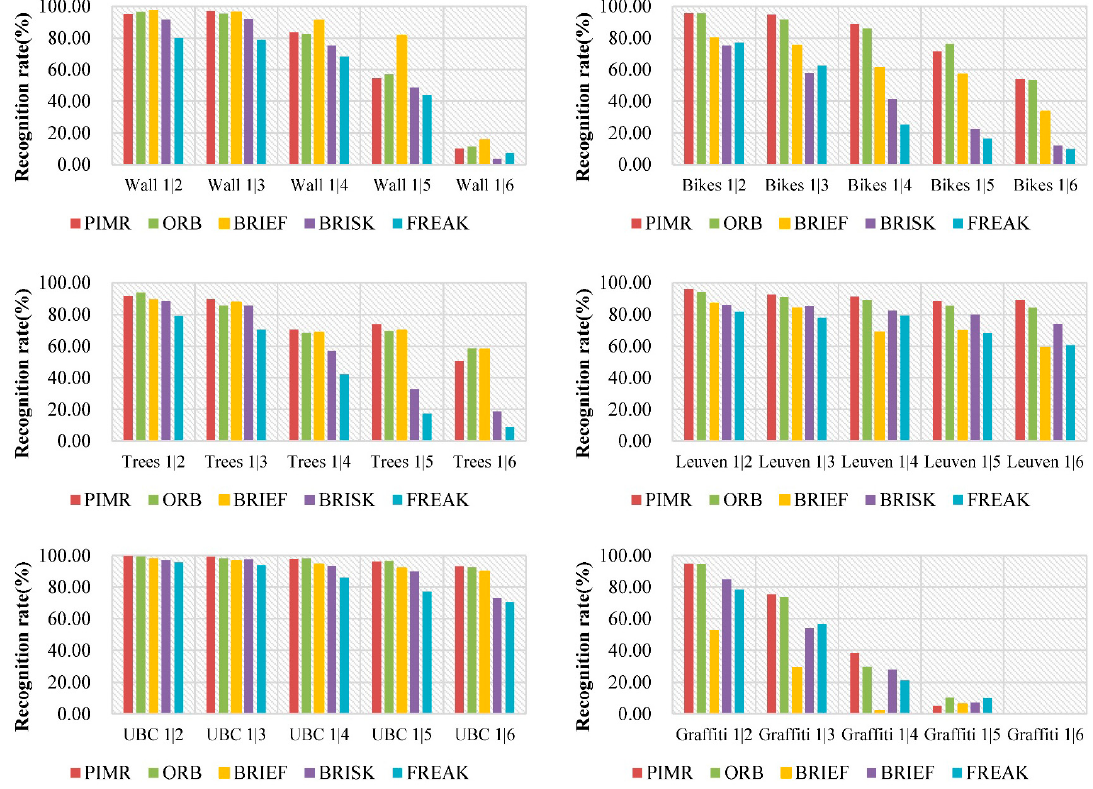
Figure 4. Recognition rates achieved by PIMR, ORB, BRIEF, BRISK and FREAK.